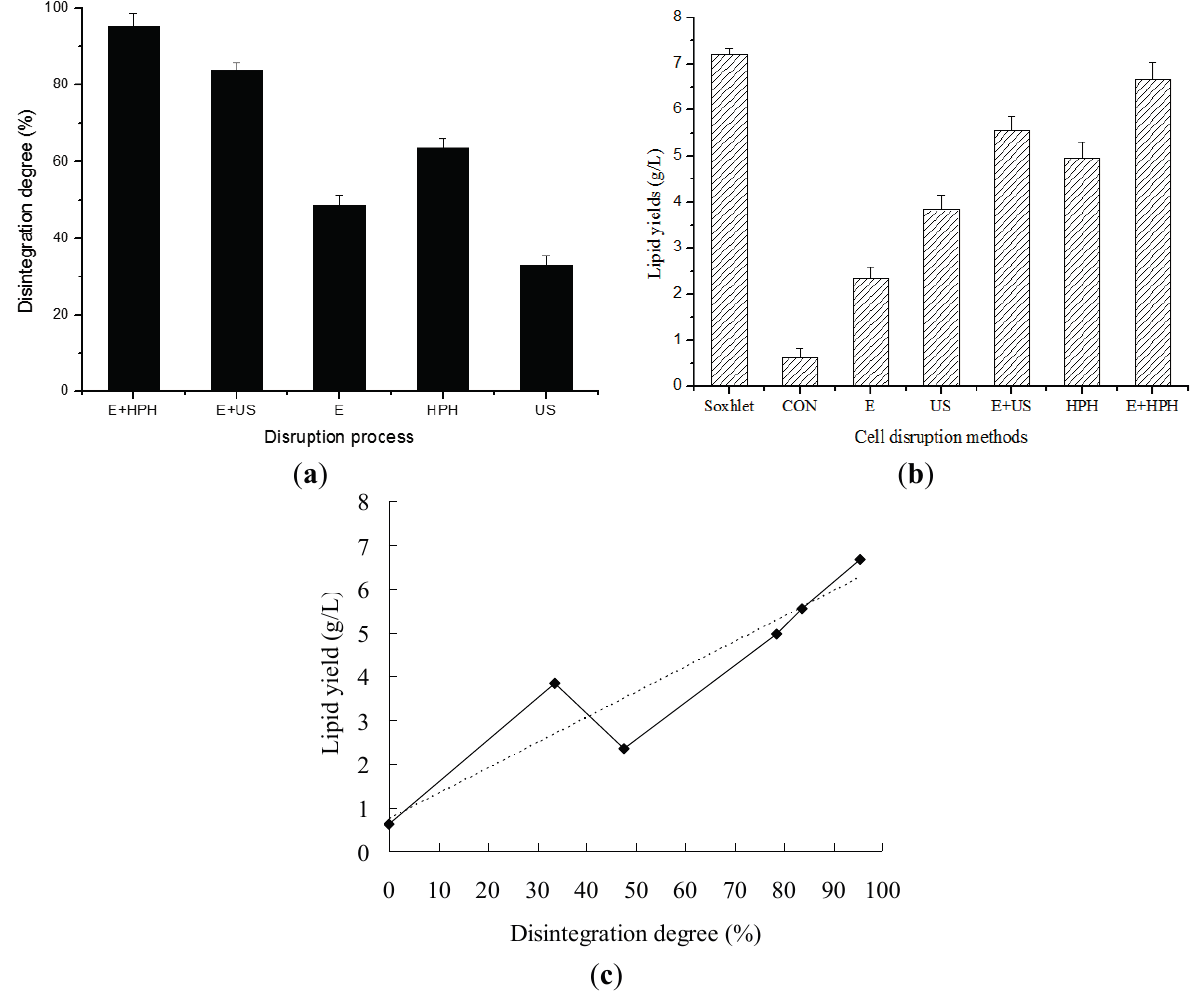
Figure 4. The cell disruption degree and lipid extraction yield in different